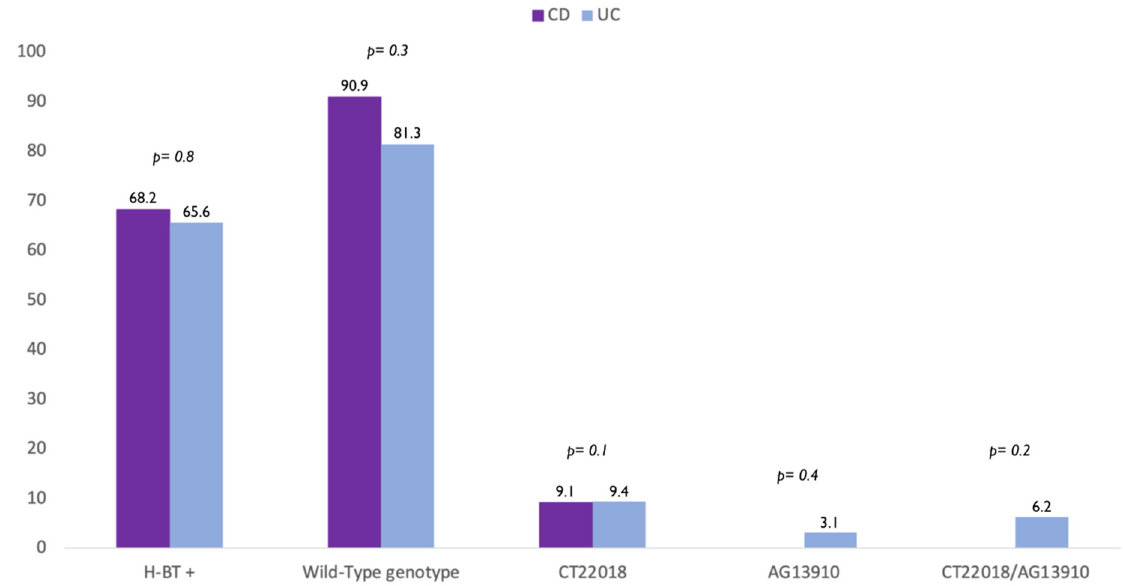
Figure 2. Difference in prevalence of positive breath test (H-BT +) and distribution of genotypes in patients with Crohn’s disease (CD) and Ulcerative colitis (UC) patients.